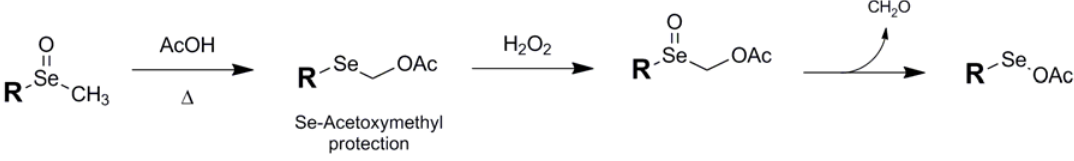
Figure 7. Formation of Se-Acetoxymethyl protection via Pummerer rearrangement and deprotection using peroxide.